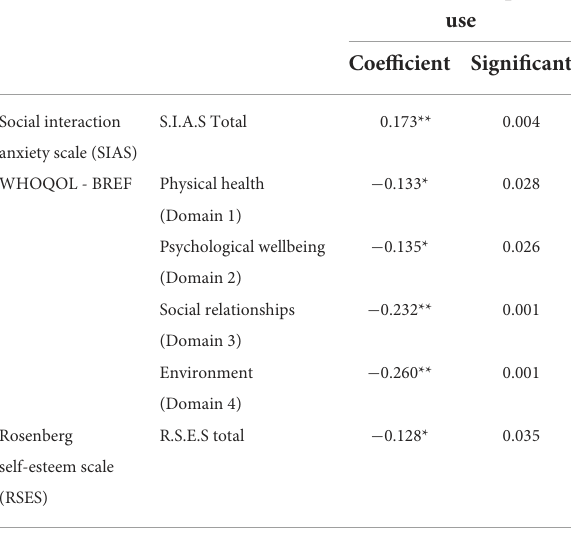
TABLE 2 Correlations study excessive smartphone use vs. factors.